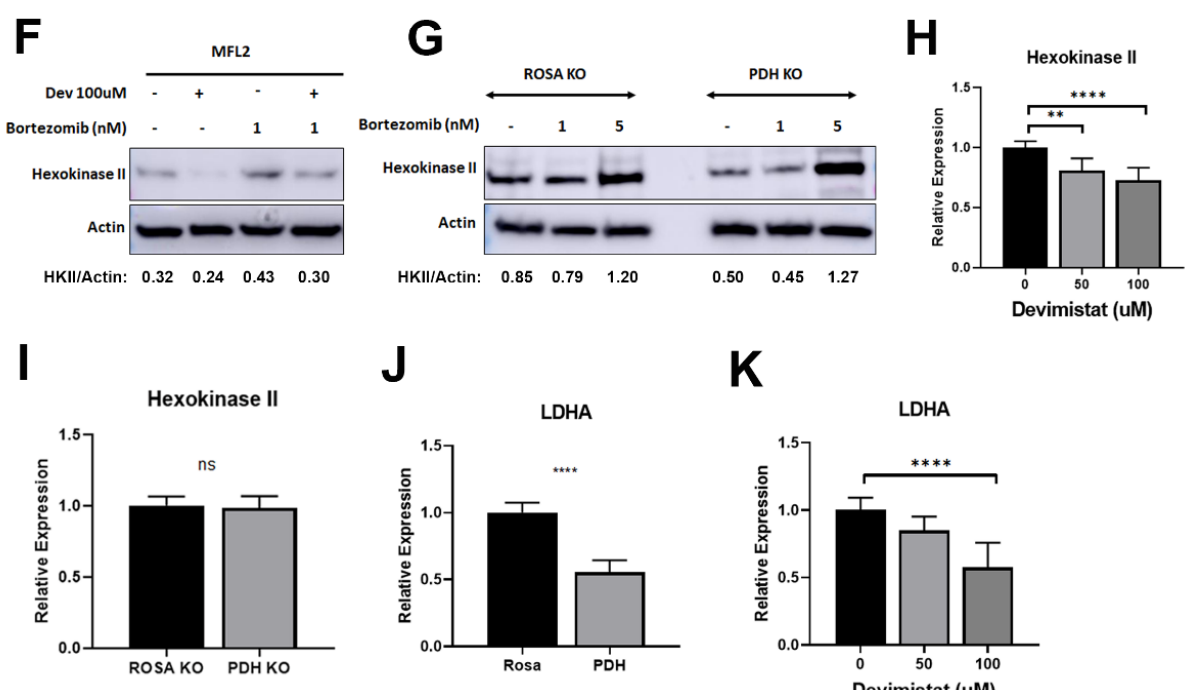
Figure 1. TCA cycle inhibition leads to decreased glycolysis glucose uptake and glucose retention. ( A , B ) Extracellular acidification rates (ECAR) following the indicated concentrations of devimistat on K662 ( A ) and OCI-AML3 ( B ) cells. Results are shown of three independent experiments, each done in triplicate. ( C ) Glucose uptake was assessed in ROSA control and PDH-deleted cells. The resulting data were normalized to ROSA control. ( D , E ) QPCR of GLUT1 in PDHA -deleted and con- trol ROSA26-deleted cells, and ( D ) MFL2 cells treated with the indicated amount of devimistat for 24 h ( E ). ( F ) Western blot of MFL2 cells treated with devimistat at 100 uM and/or bortezomib at 1 nM for 24 h. Relative densitometry readings below actin. ( G ) Western blot of ROSA and PDH KO cells treated with bortezomib at 1 or 5 nM for 24 h. Relative densitometry readings below actin. ( H ) QPCR analysis of Hexokinase II in MFL2 cells treated with the indicated amount of devimistat for 24 h. ( I ) QPCR analysis of Hexokinase II in ROSA control and PDH-deleted cells. ( J ) QPCR analysis